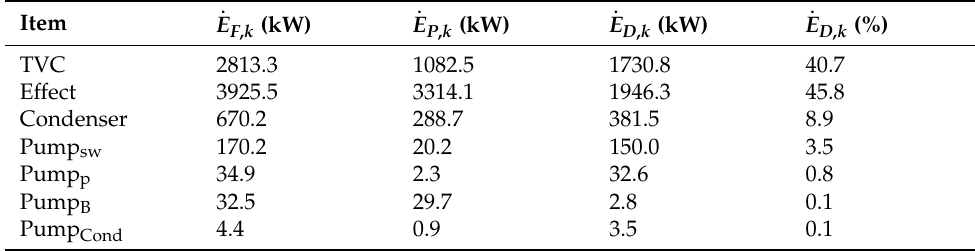
Table 4. Exergetic analysis results.